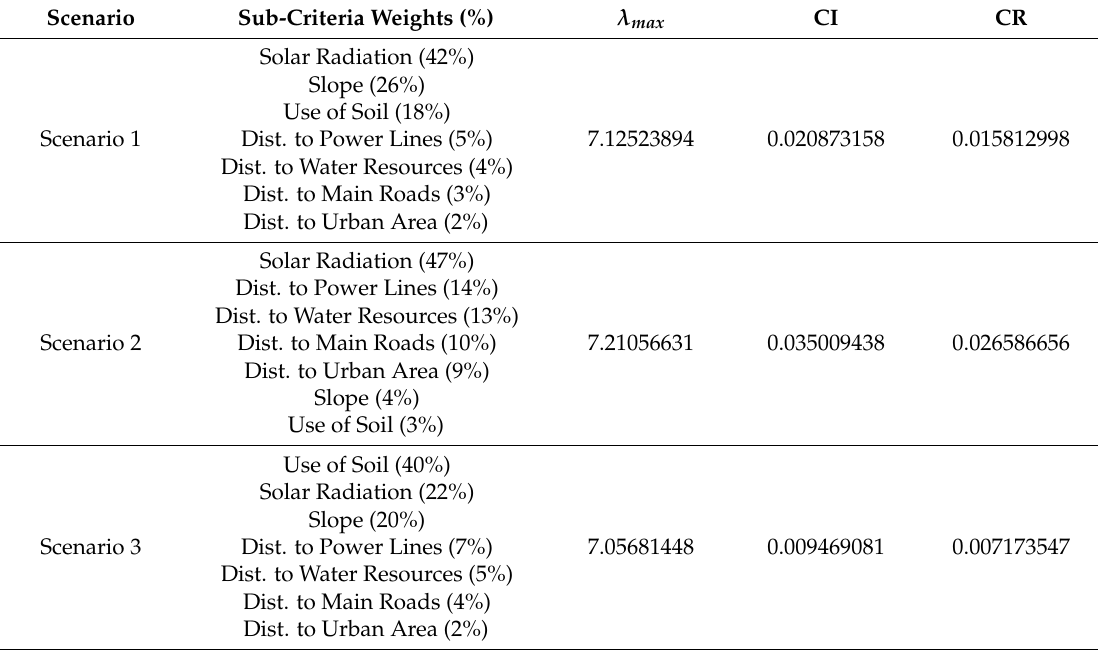
Table 8. Sub-criteria Weighs and Higher Eigenvalue ( λ max ), Consistency Index (CI) and Random Consistency Index (CR)